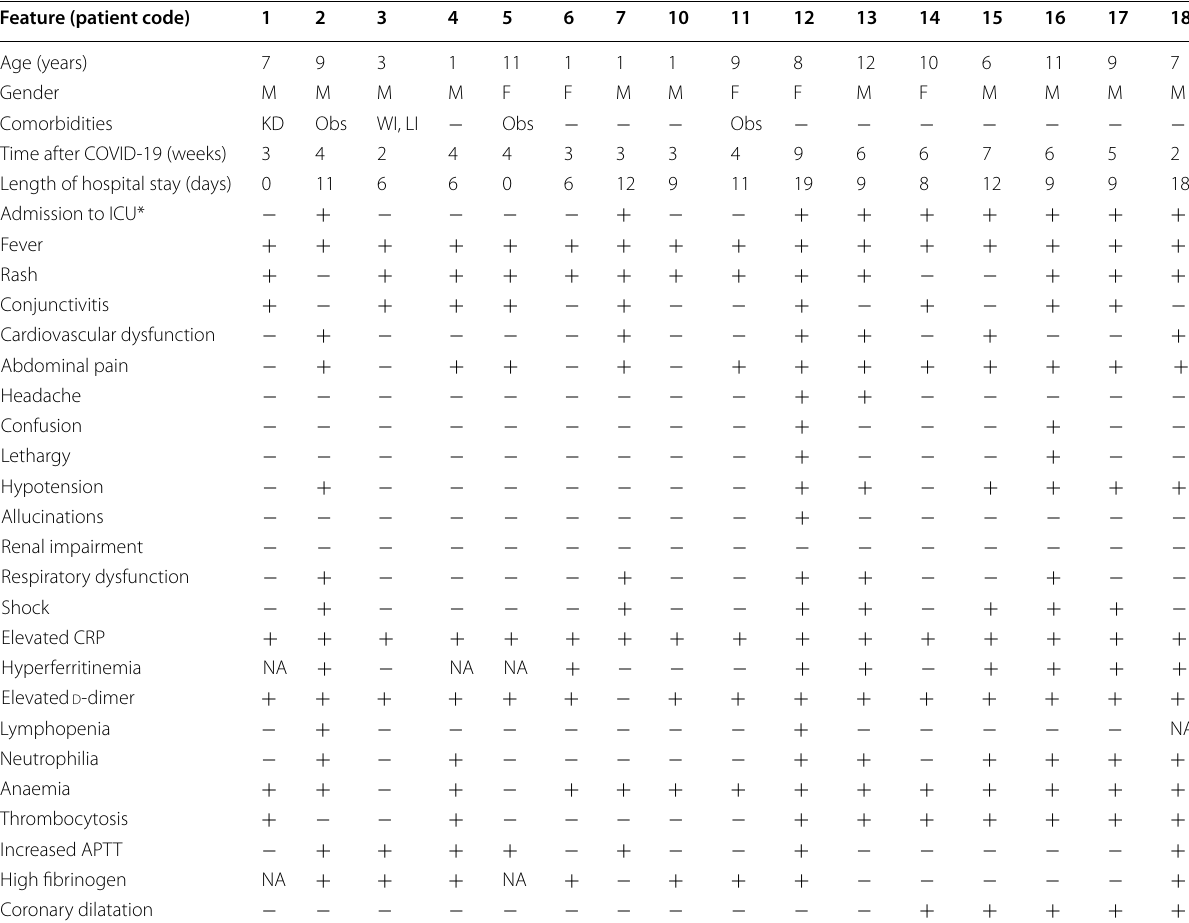
Table 1 Summary features seen in the Brazilian MIS‑C